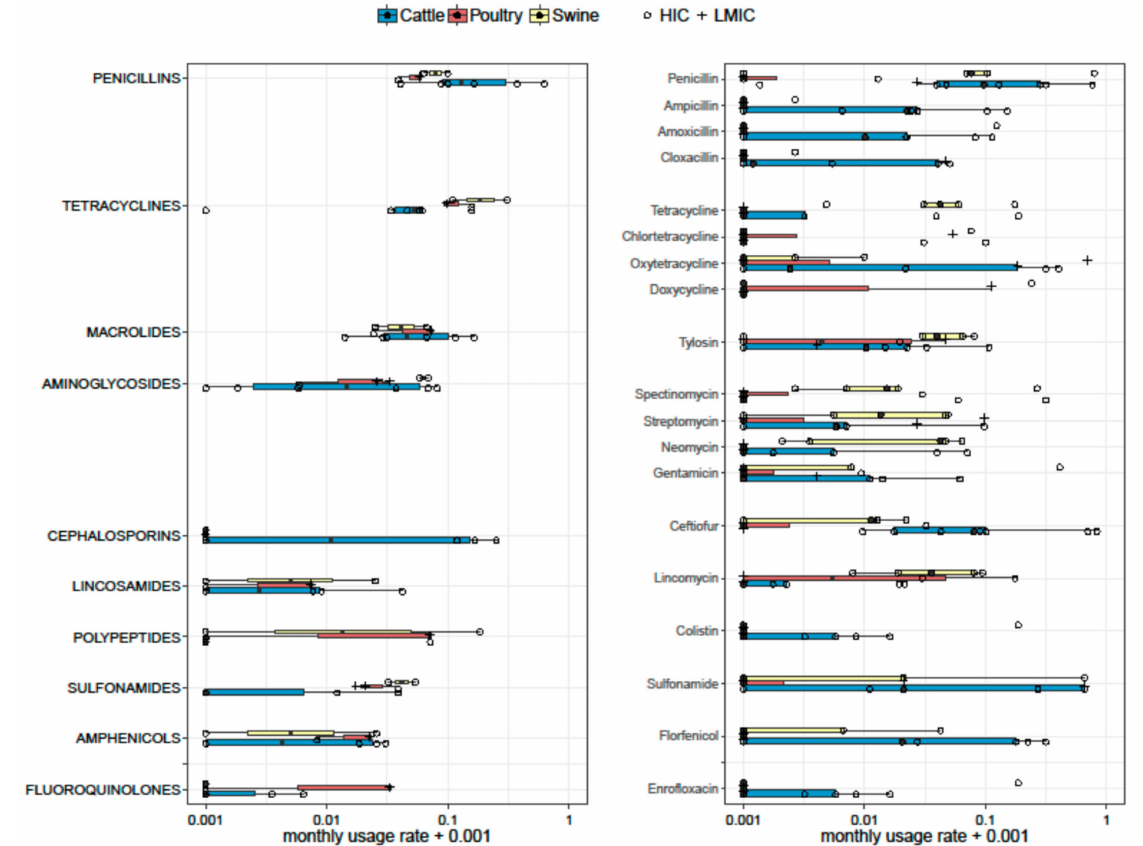
Figure 2. Boxplots representing monthly usage rage ( UR ) of antimicrobials ( Right ) and antimicrobial classes ( Left ). Six, three, and two estimates on antimicrobial classes were available for cattle, poultry, and swine, respectively. Nine, five, and four estimates on specific antimicrobials were available for cattle, swine, and poultry, respectively. The thickness of the boxes reflects the number of